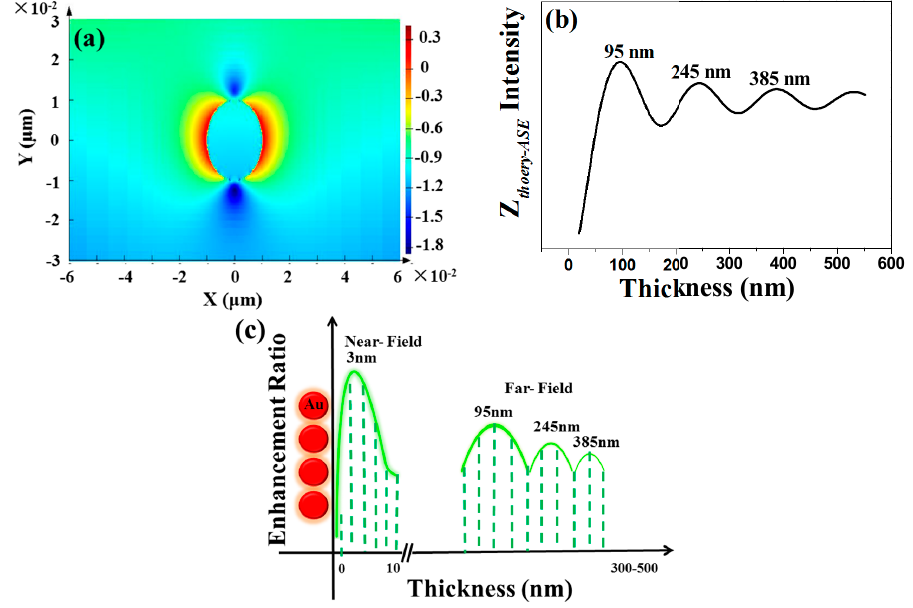
Figure 6. Theoretical simulation of ( a ) near-electric field profile, ( b ) far-field, ( c ) distribution in devices.